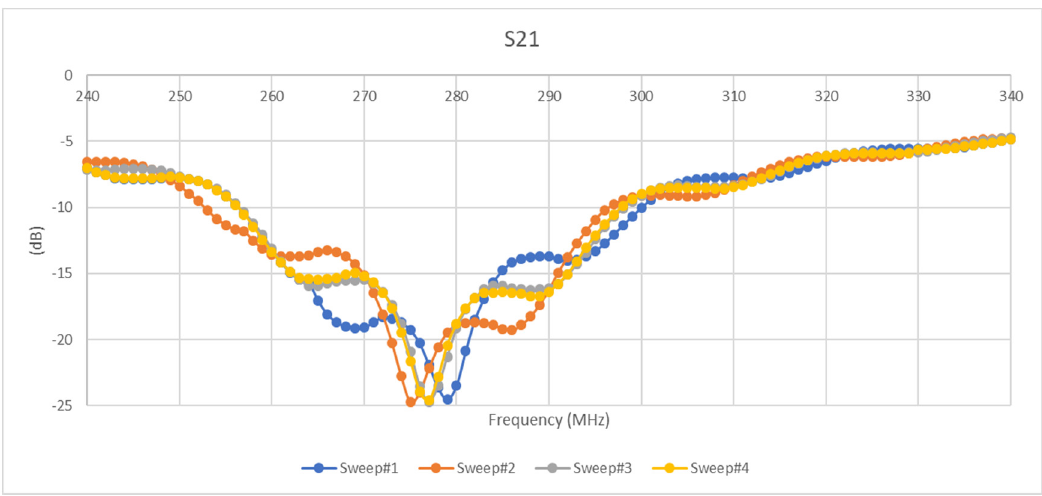
Figure 15. S11 results of sinusoidal excitation.